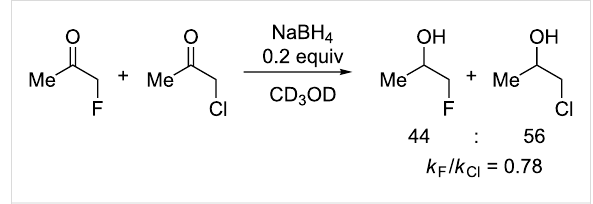
The highest energy conformations of α -haloacetophenones have a O=C–C–X dihedral angle of 60–70° and place the C–X bond